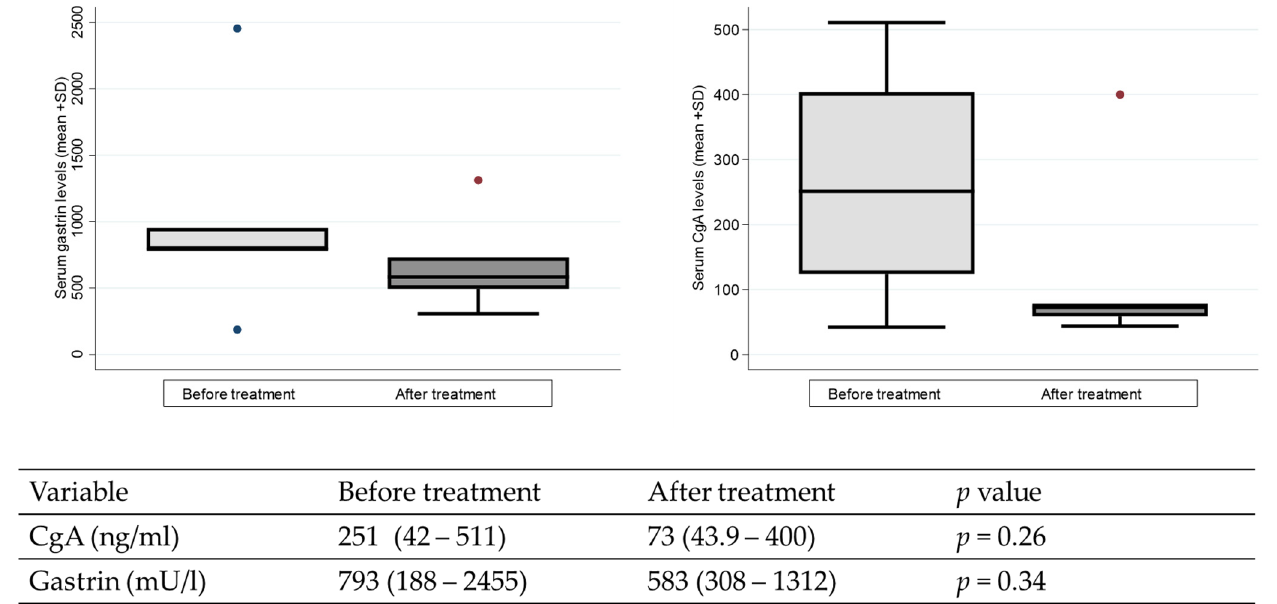
Figure 2. Gastrin and chromogranin A levels before and after treatment with somatostatin ana- logues. CgA: Cromogranin A. CgA: Cromogranin